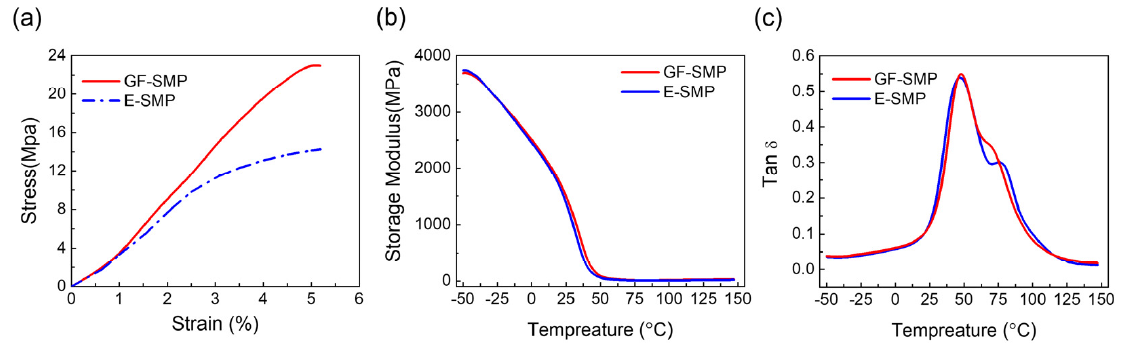
Figure 4. Comparison of mechanical properties of GF-SMP and E-SMP. ( a ) Comparison of stress–strain curves for GF-SMP and E-SMP samples, ( b ) Storage modulus plotted against the temperature for GF-SMP and E-SMP samples, ( c ) Loss factor plotted against temperature for GF-SMP and E-SMP samples.